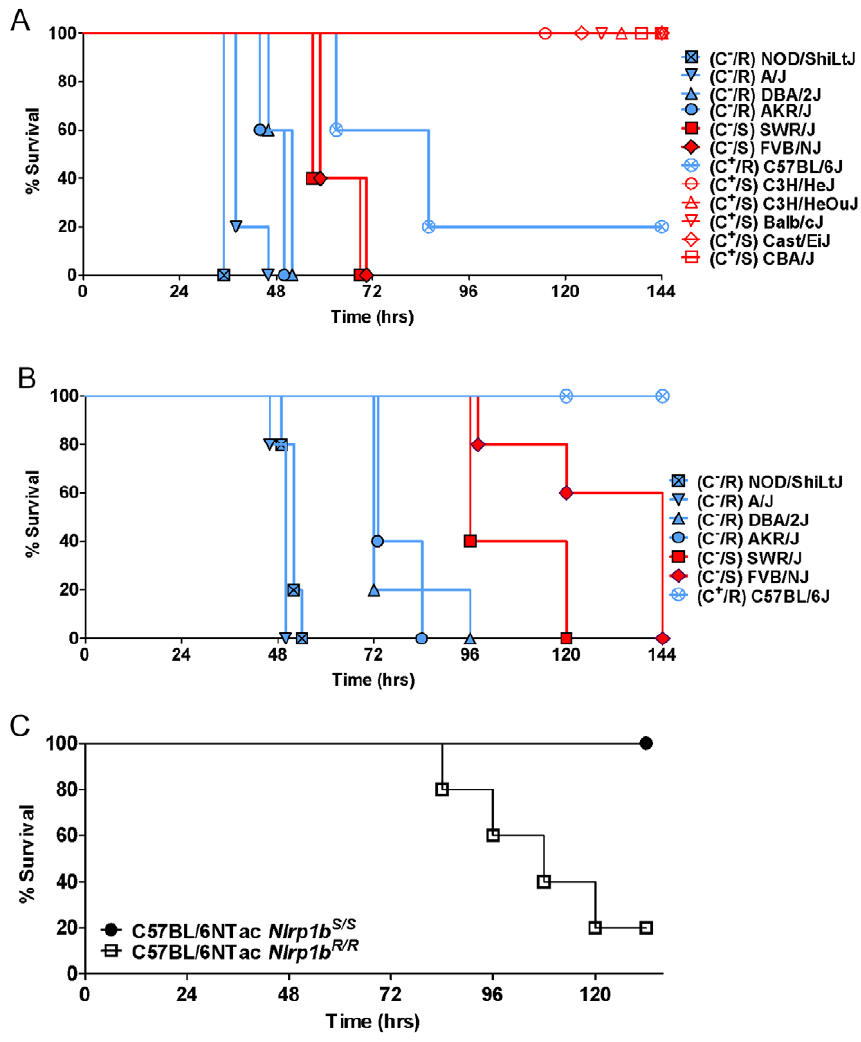
Figure 1. Susceptibility of inbred, C57BL/6NTac Nlrp1b S/S and C57BL/6NTac Nlrp1b R/R mouse strains to subcutaneous spore infection. Mice were injected SC with 2 6 10 6 (A) or 2 6 10 5 (B) spores and monitored for malaise. R indicates Nlrp1b R/R genotype and LT-resistant macrophages (plotted in blue). S indicates Nlrp1b S/S genotype and LT-sensitive macrophages (plotted in red). C 2 and C + indicate complement C5 status, with closed symbols used for C 2 strains and open circles for C + strains. For the representative experiments shown, n=5 for all strains. Similar results were obtained in three independent experiments utilizing all strains except CBA/J, C3H/HeJ and C3H/HeOuJ, which were not used in subsequent studies. For panel A, logrank-based P-values comparing survival curves of any of the NOD/ShiLtJ, A/J, DBA/2J, and AKR/J mice (C 2 , Nlrp1b R/R ) with the SWR/J and FVB/NJ (C 2 , Nlrp1b S/S ) mice are , 0.0035. P-values comparing the C57BL/6J mice (C + , Nlrp1b R/R ) to any of C3H/HeJ, C3H/HeOuJ, Balb/cJ, Cast/EiJ, and CBA/J mice (C + , Nlrp1b S/S ) are , 0.015. All survival curves for C + mice are significantly different than all survival curves for C 2 mice (P-values , 0.003) except C57BL/6J mice compared to FVB/NJ or SWR/J (P-value =0.063 for both comparisons). For panel B, P-values comparing survival curves of any of the NOD/ShiLtJ, A/J, and DBA/2J mice (C 2 , Nlrp1b R/R ) with the SWR/J and FVB/NJ mice (C 2 , Nlrp1b S/S ) are , 0.004. Comparison of survival of C57BL/6J mice to all other mice except FVB/NJ yields P-values , 0.0025. P-value for C57BL/6J compared to FVB/NJ survival is 0.0034. (C) C57BL/ 6NTac Nlrp1b S/S and C57BL/6NTac Nlrp1b R/R mice (n=5/strain) were injected with 1 6 10 7 spores and monitored. P-value (Logrank Test)